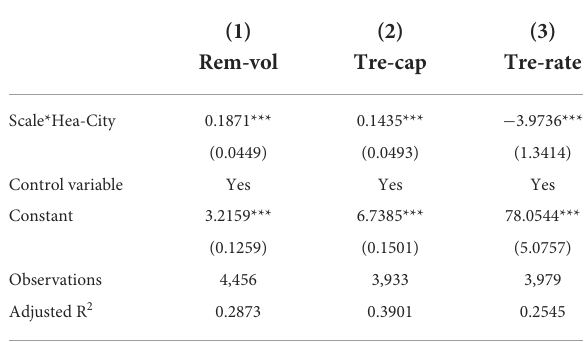
TABLE 10 Heterogeneity by city